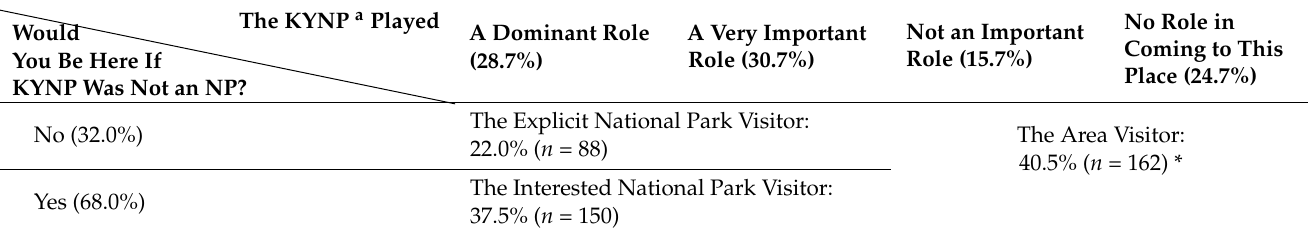
Table 1. National park affinity segments with segment sizes ( n =